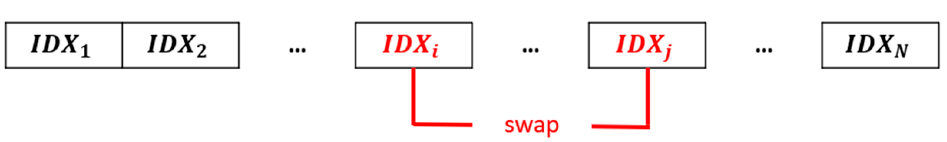
Figure 17. The TSA steps.